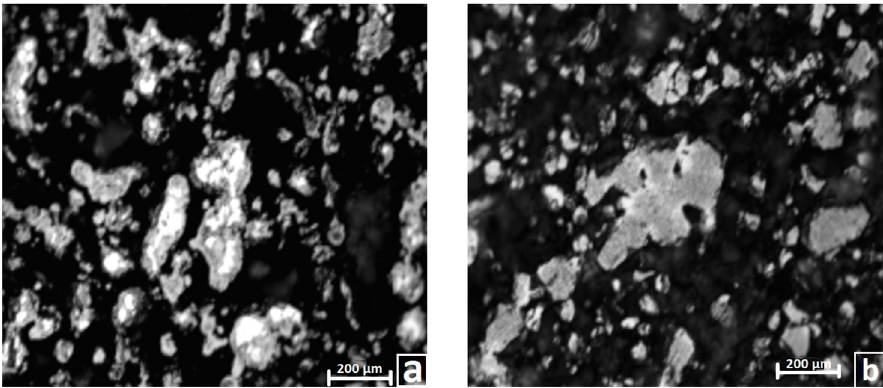
Figure 9. Microstructure of nitrided chromium. ( a )—0.2 MPa; ( b )—5.0 MPa.